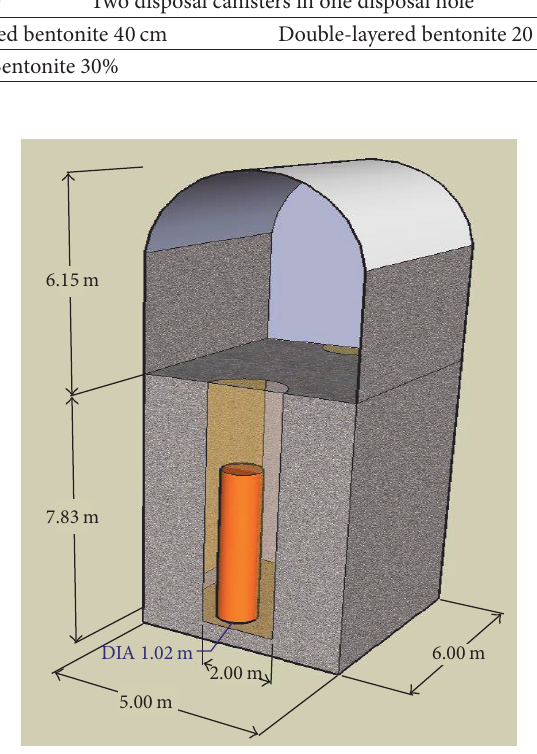
Figure 1: Concept of unit module